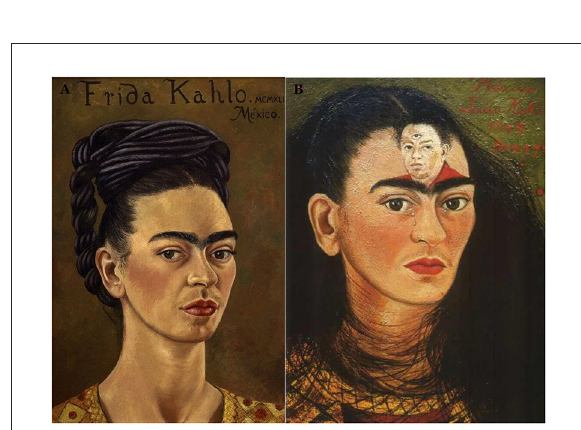
FIGURE3 Two self-portraits of Frida Kahlo that scored the highest both in terms of red-ness and perceived luminance are (A) “Self-portrait dedicated to Sigmund Firestone” (1940) and (B) “Self-portrait as a Tehuana” (1943). Both were painted in 1940 (although the second one was completed in 1943) when, deeply hurt by the string of infidelities of her husband Diego Rivera, she filed for divorce. Frida went on to remarry him in December 1940 following the mutual agreement that they would not have